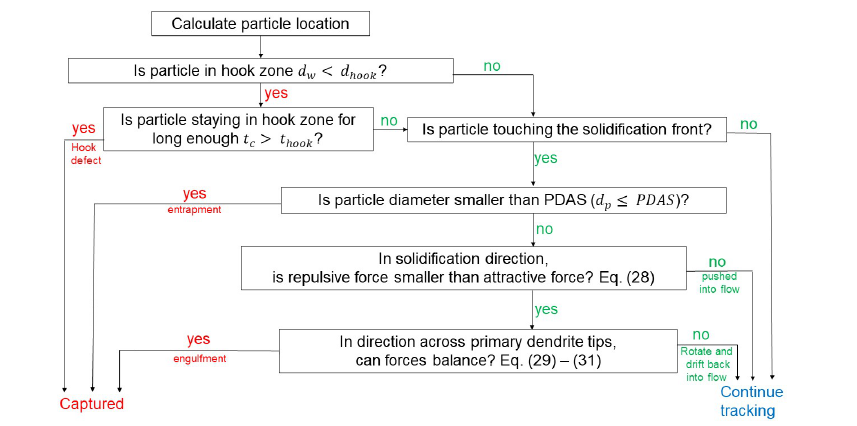
Figure 4. Capture-mechanism flow chart.